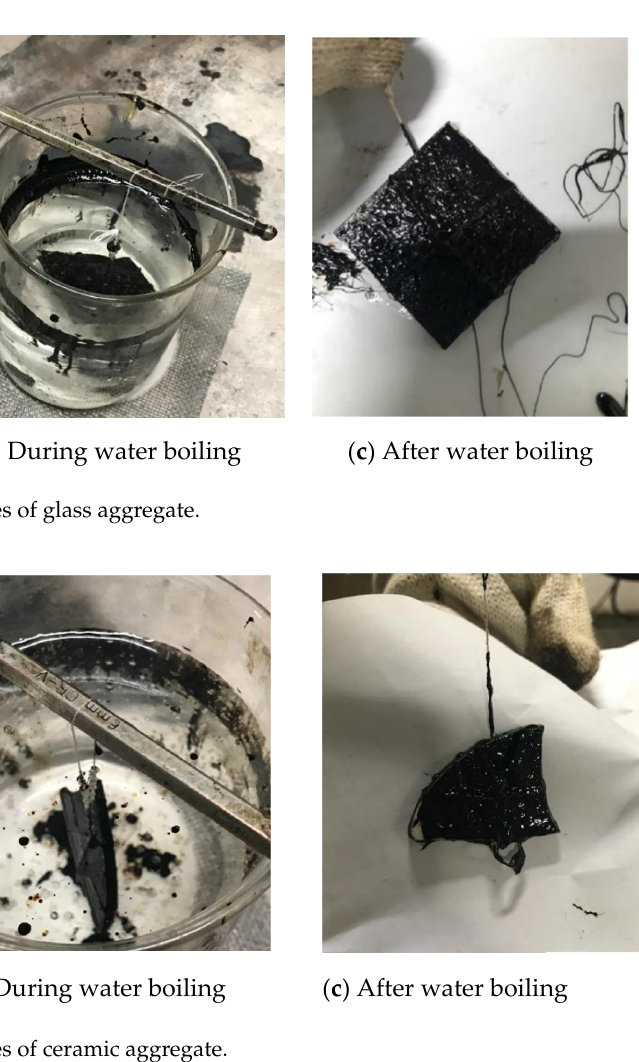
Figure 14. Test pictures of limestone aggregate.